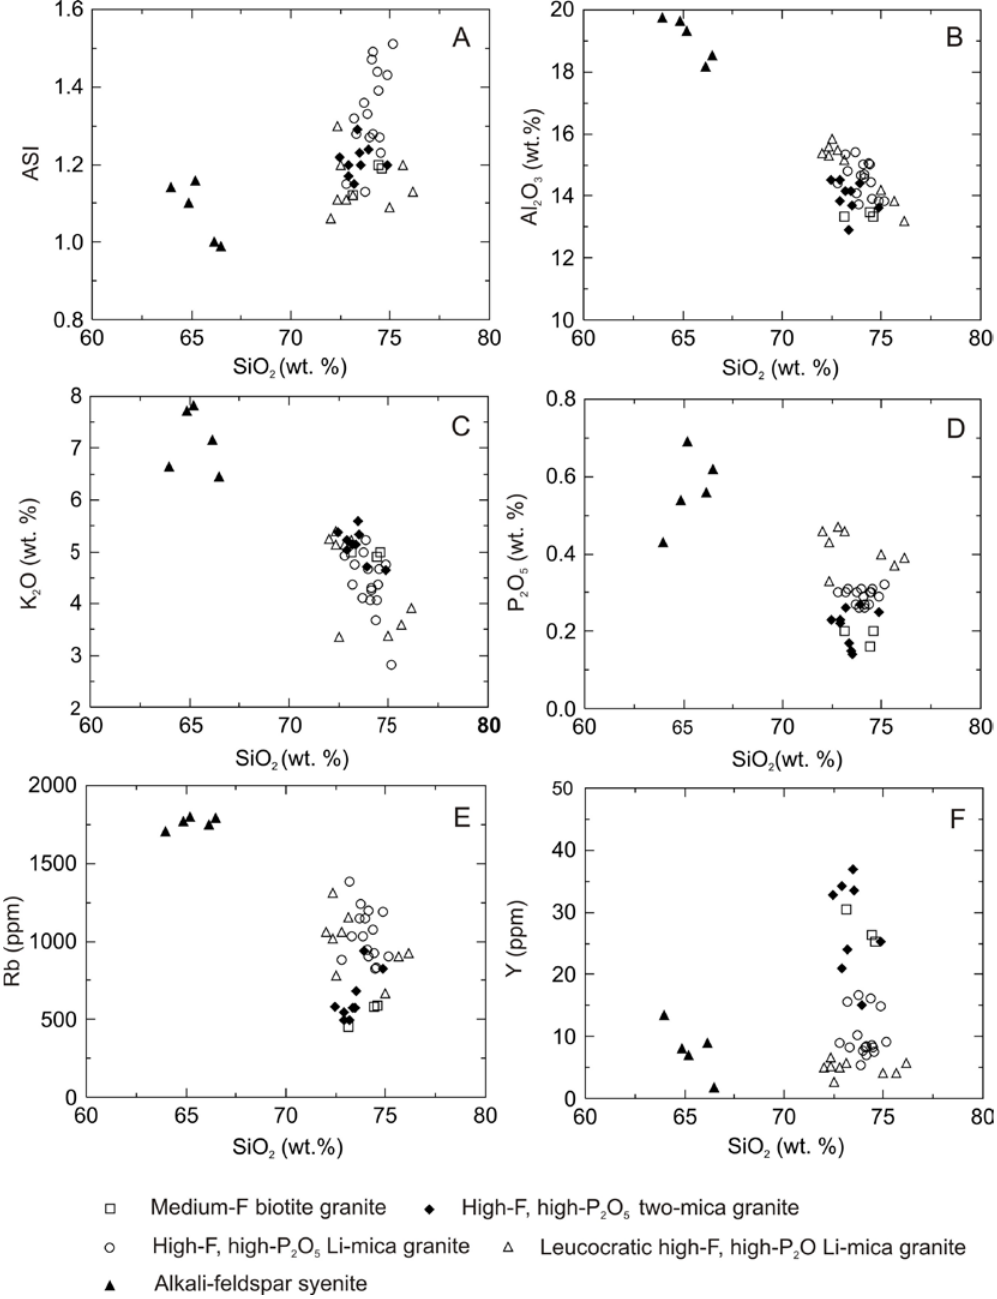
Figure 4. ( A ) Binary plot of ASI vs. SiO 2 for granitic rocks of the Krudum granite body, ( B ) Binary plot of Al 2 O 3 vs. SiO 2 for granitic rocks of the Krudum granite body, ( C ) Binary plot of K 2 O vs. SiO 2 for granitic rocks of the Krudum granite body, ( D ) Binary plot of P 2 O 5 vs. SiO 2 for granitic rocks of the Krudum granite body ( E ) Binary plot of Rb vs. SiO 2 for granitic rocks of the Krudum granite body, ( F ) Binary plot of Y vs. SiO 2 for granitic rocks of the Krudum granite body.